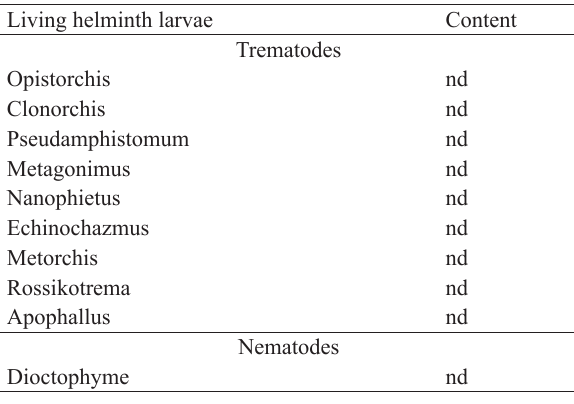
Table 1 Environmental safety indicators for pork packed Table 2 Parasitological indicators of carp